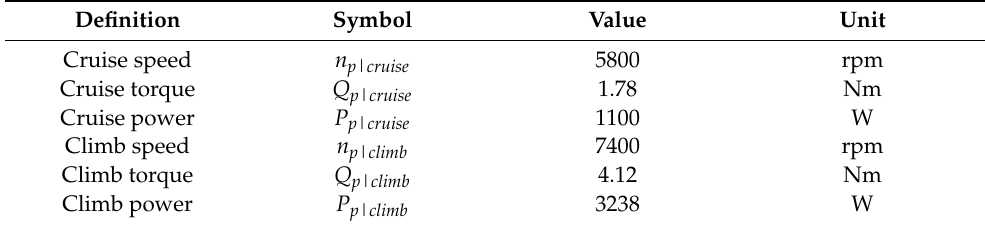
Table A3. APC22x10E propeller